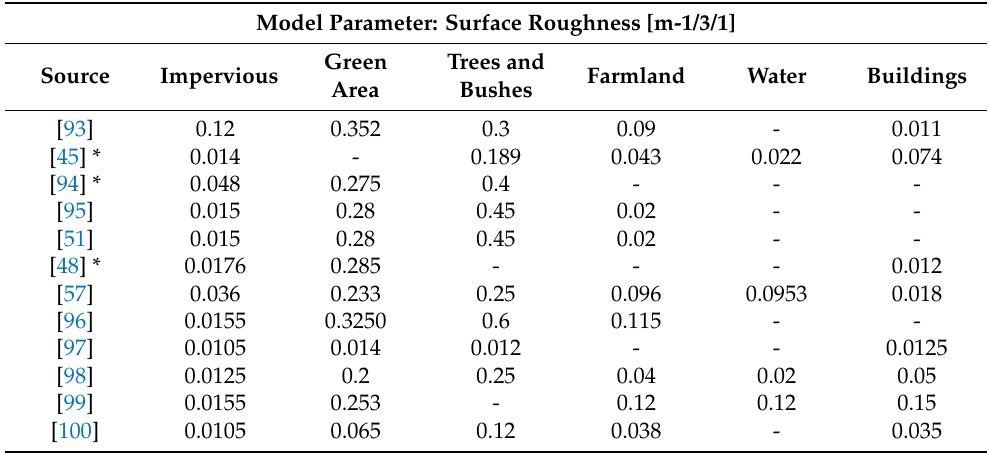
Table A1. Overview of the model parameters surface roughness for urban flood models.